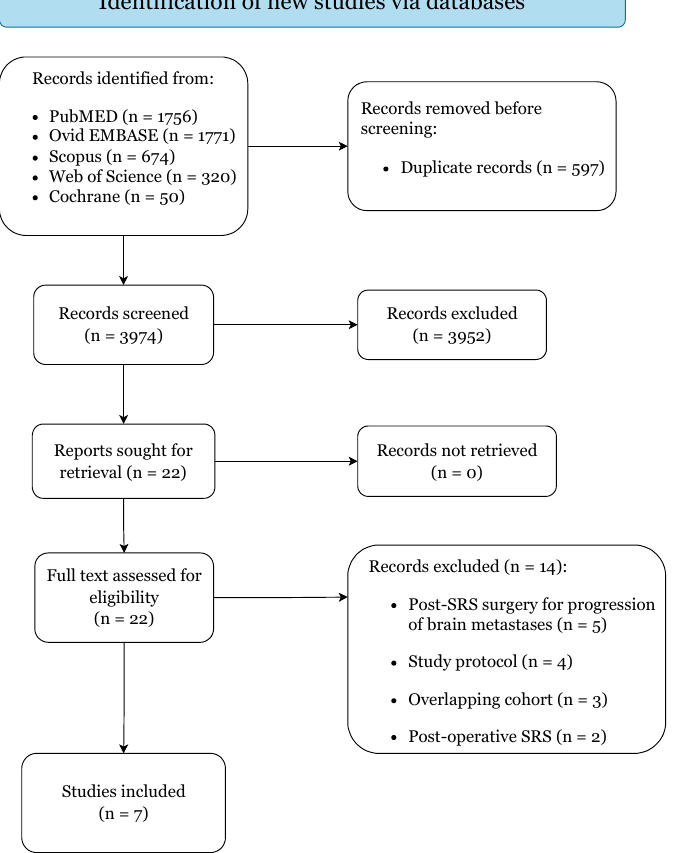
Figure 1. PRISMA 2020 Flow-Diagram.